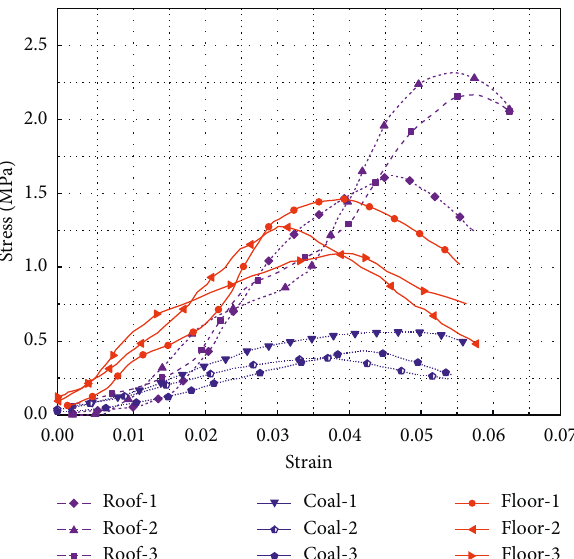
8: Shear test fitting curves of coal and